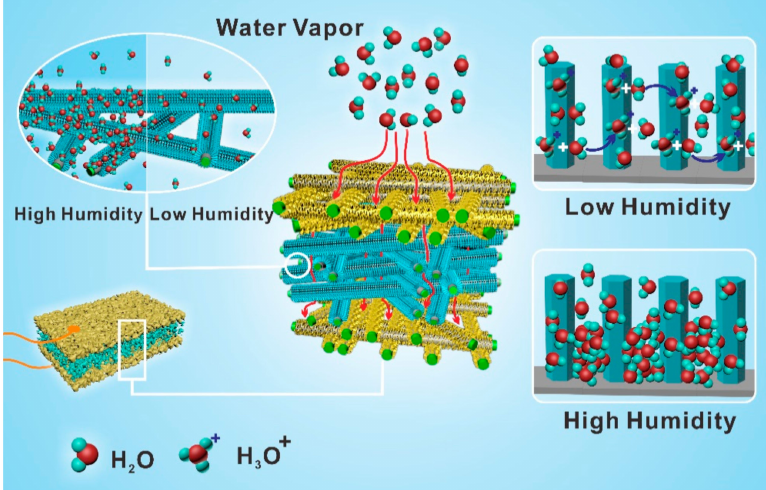
Figure 5. Schematic diagram of the sensing mechanism of Ag@Fe 3 O 4 -MS at high and low